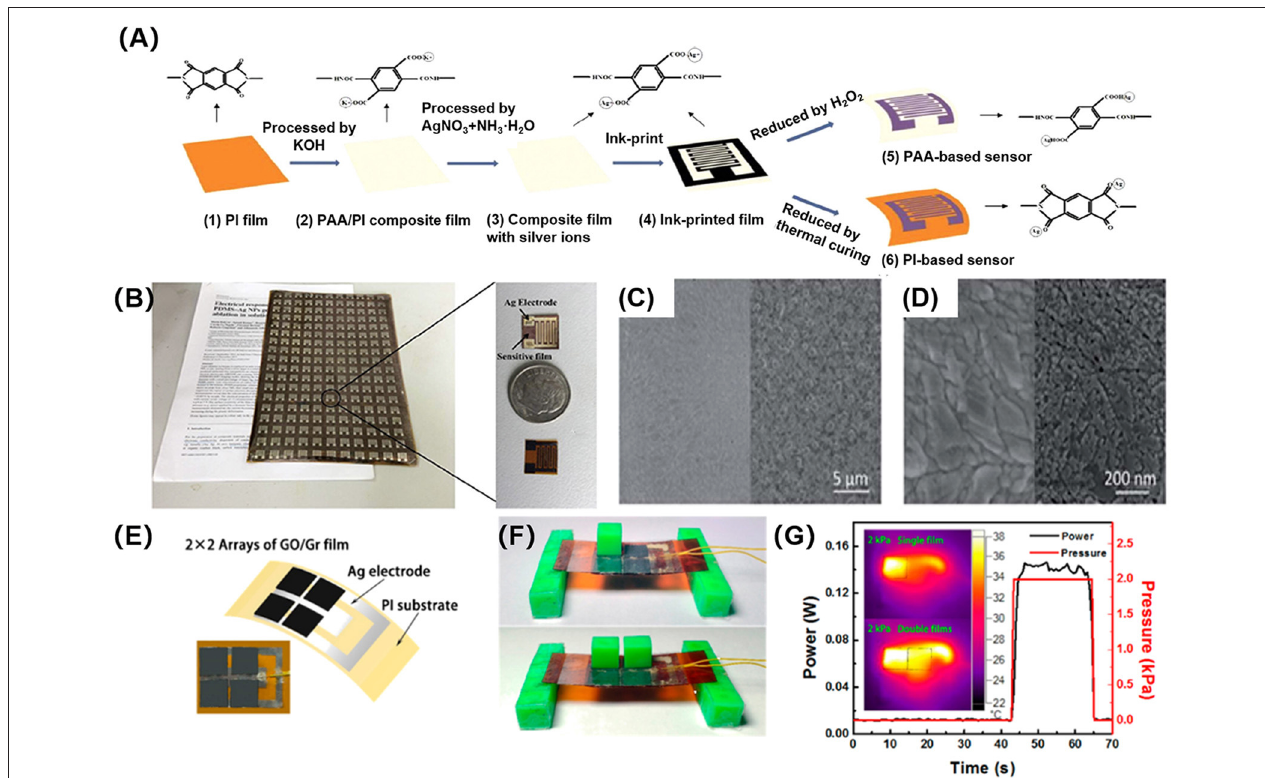
FIGURE 11 | (A) Procedure of fabricating humidity sensors with Ag interdigitated electrodes using the ion-exchange method. (B) Optical photography of an Ag interdigitated electrode array (Yang et al., 2015). Reproduced with the permission of 2015 Elsevier B.V. (C,D) SEM images of Ag film before and after Au coating. (E) Graphene/graphene oxide resistance sensitive film array on Ag electrodes. (F,G) Demonstration of an advanced electric blanket and thermal infrared images with loading pressure (Liu et al., 2017). Reproduced with the permission of the American Chemical Society.